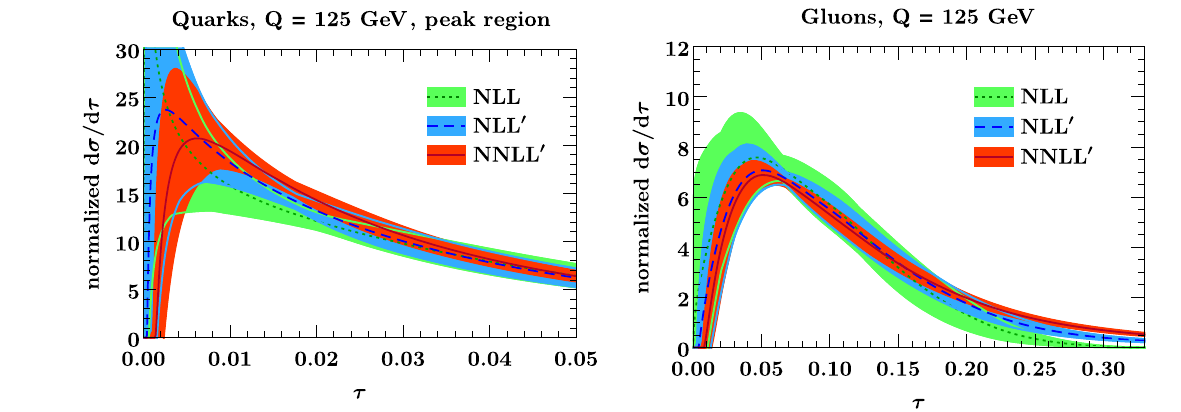
the plot range to τ < 0 . 05. The bands indicate the perturbative uncer- tainty at each order, obtained using Eq.